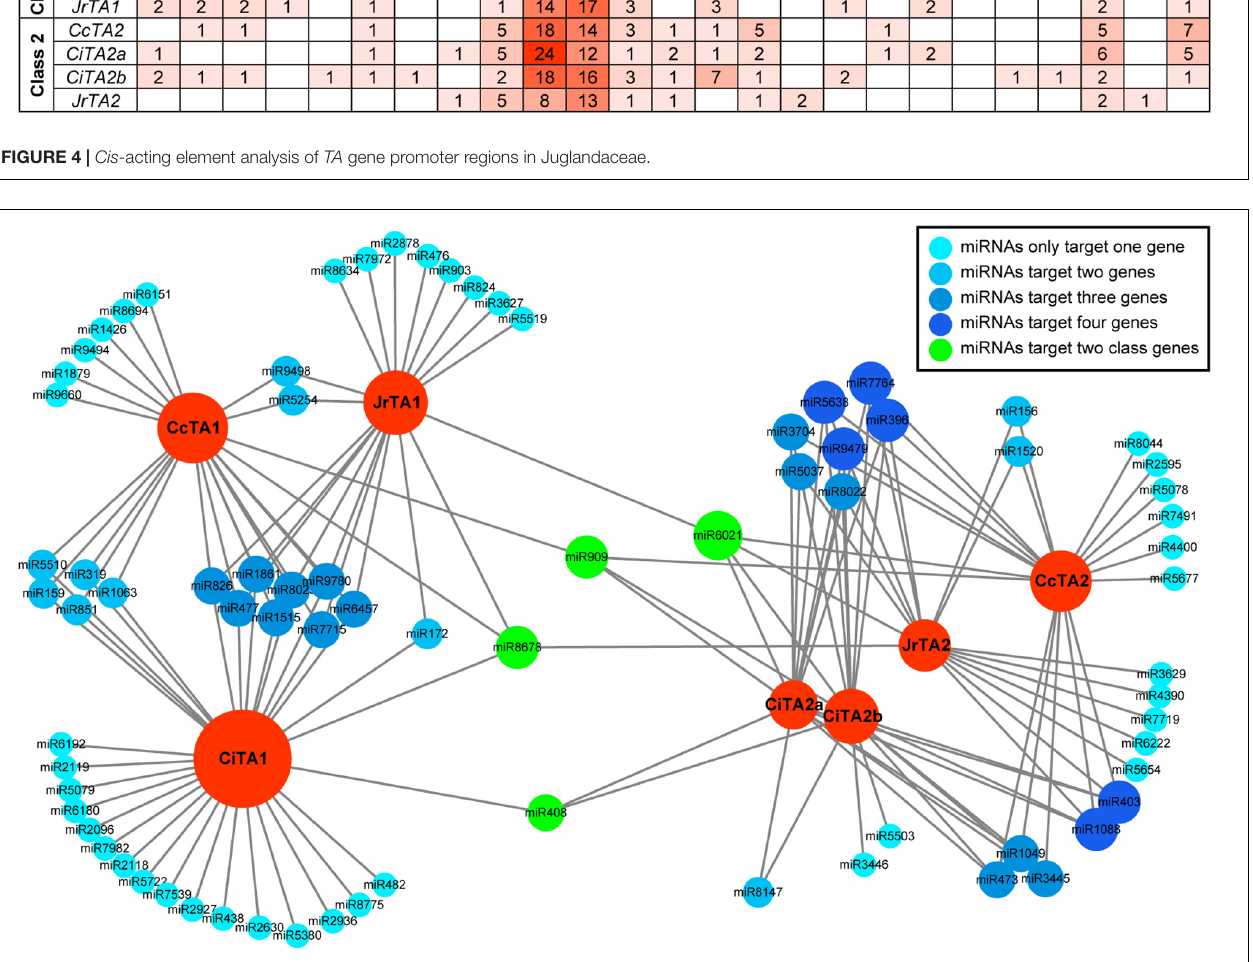
FIGURE 5 | Target network between TAs and potential miRNAs in Juglandaceae. Red circles represented TA genes; other circles denoted potential miRNAs, and different colors indicated the co-regulation